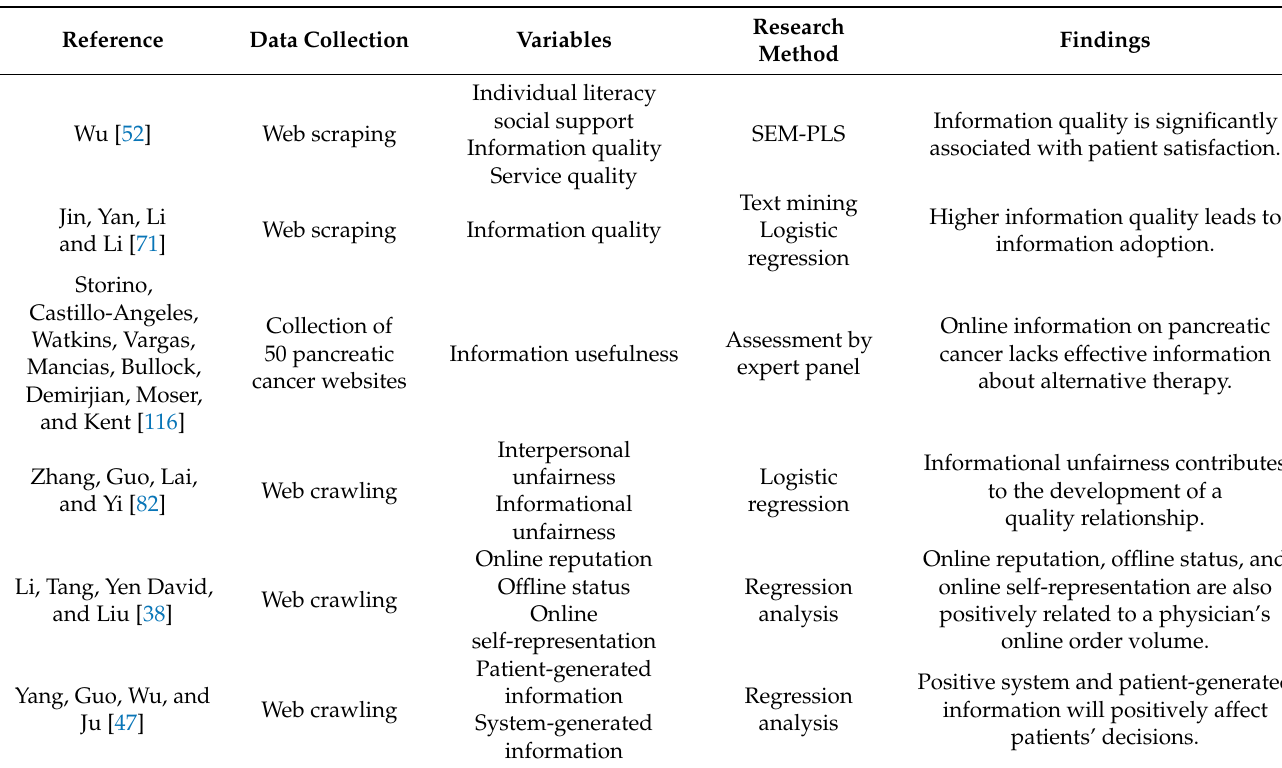
Table A1. Summary of e-health literature from 2010 to 2020 on physician rating websites and patient choice regarding health